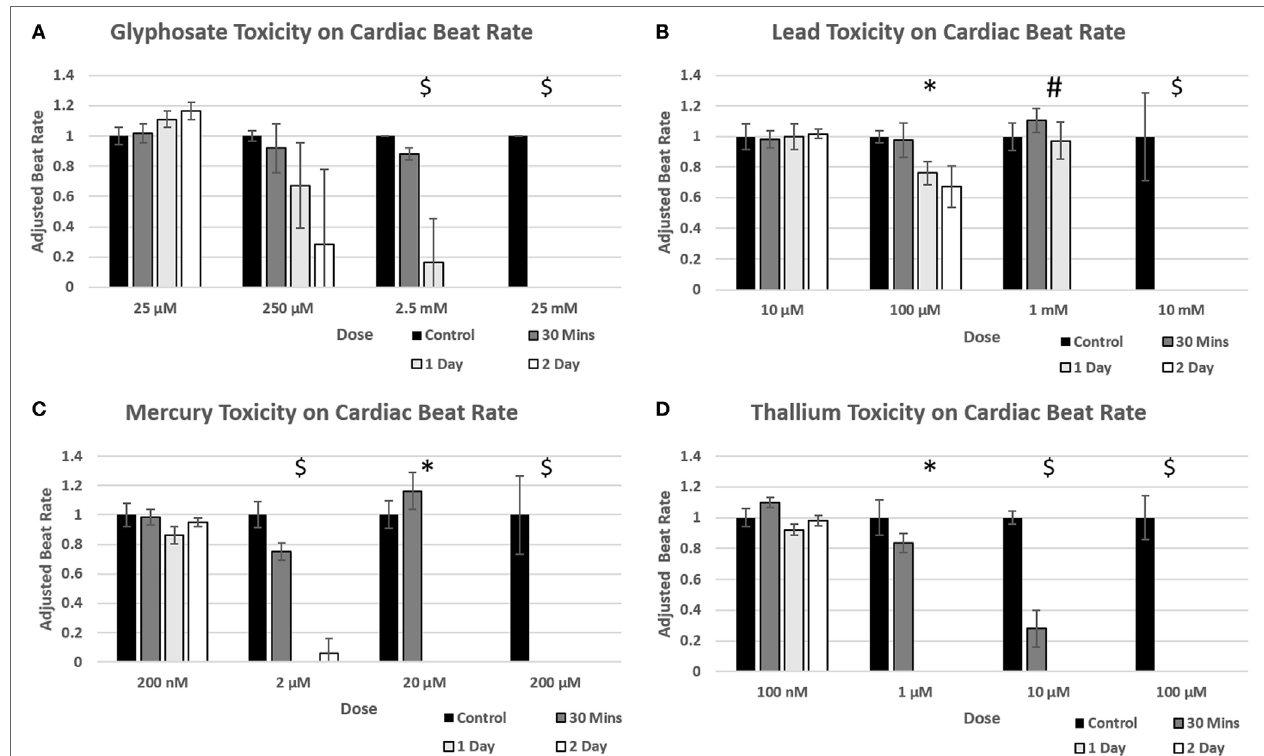
FigUre 5 | Environmental toxin influence on cardiac organoid beating kinetics. Figure 4 demonstrates the effect of glyphosate (a) , lead (B) , mercury (c) , and thallium (D) on cardiac organoid beat rate. All values ( n = 3) were taken over 20 s videos and multiplied by three to find per minute. The adjusted rate is calculated by taking average value of each condition and dividing over the control average. A T -test was performed to determine significance between control rates and time after drug was added. Statistical significance: # p < 0.05 at 2 days; * p < 0.05 at 1 day; $ p < 0.05 at 30